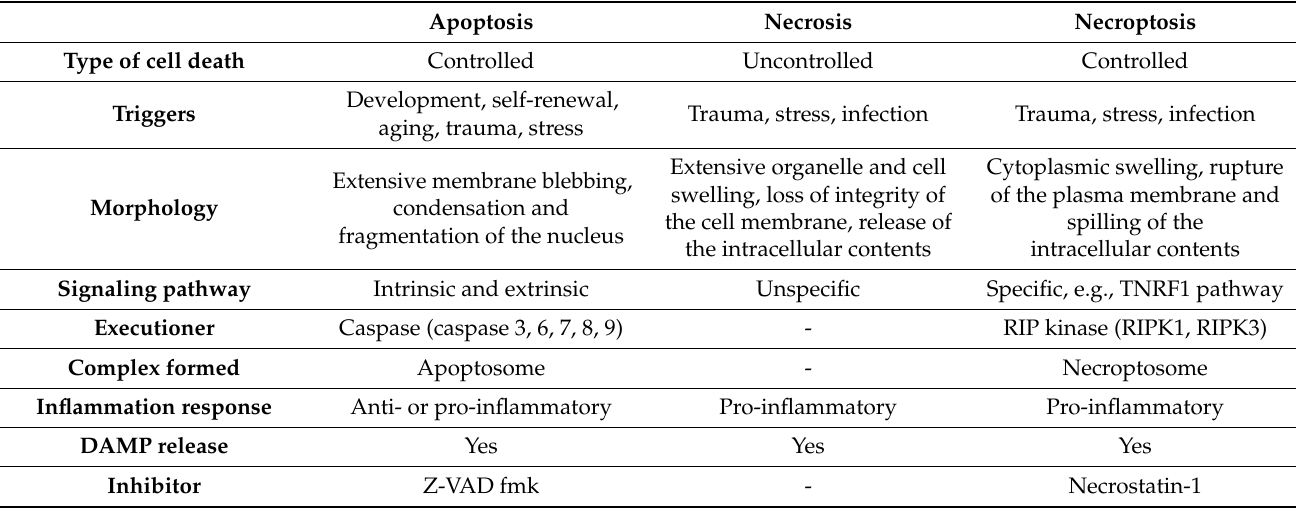
Table 1. Differences between apoptosis, necrosis and